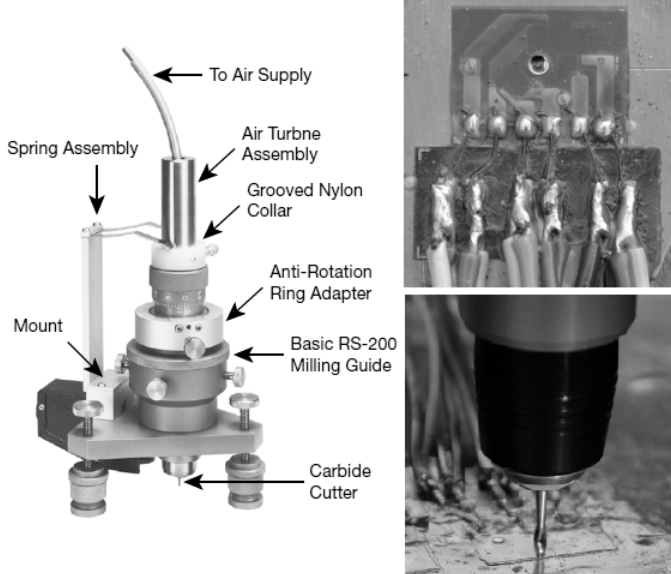
Figure 2. RS-200 Milling Guide ( left ) and hole-drilled strain gauge rosette ( right ).